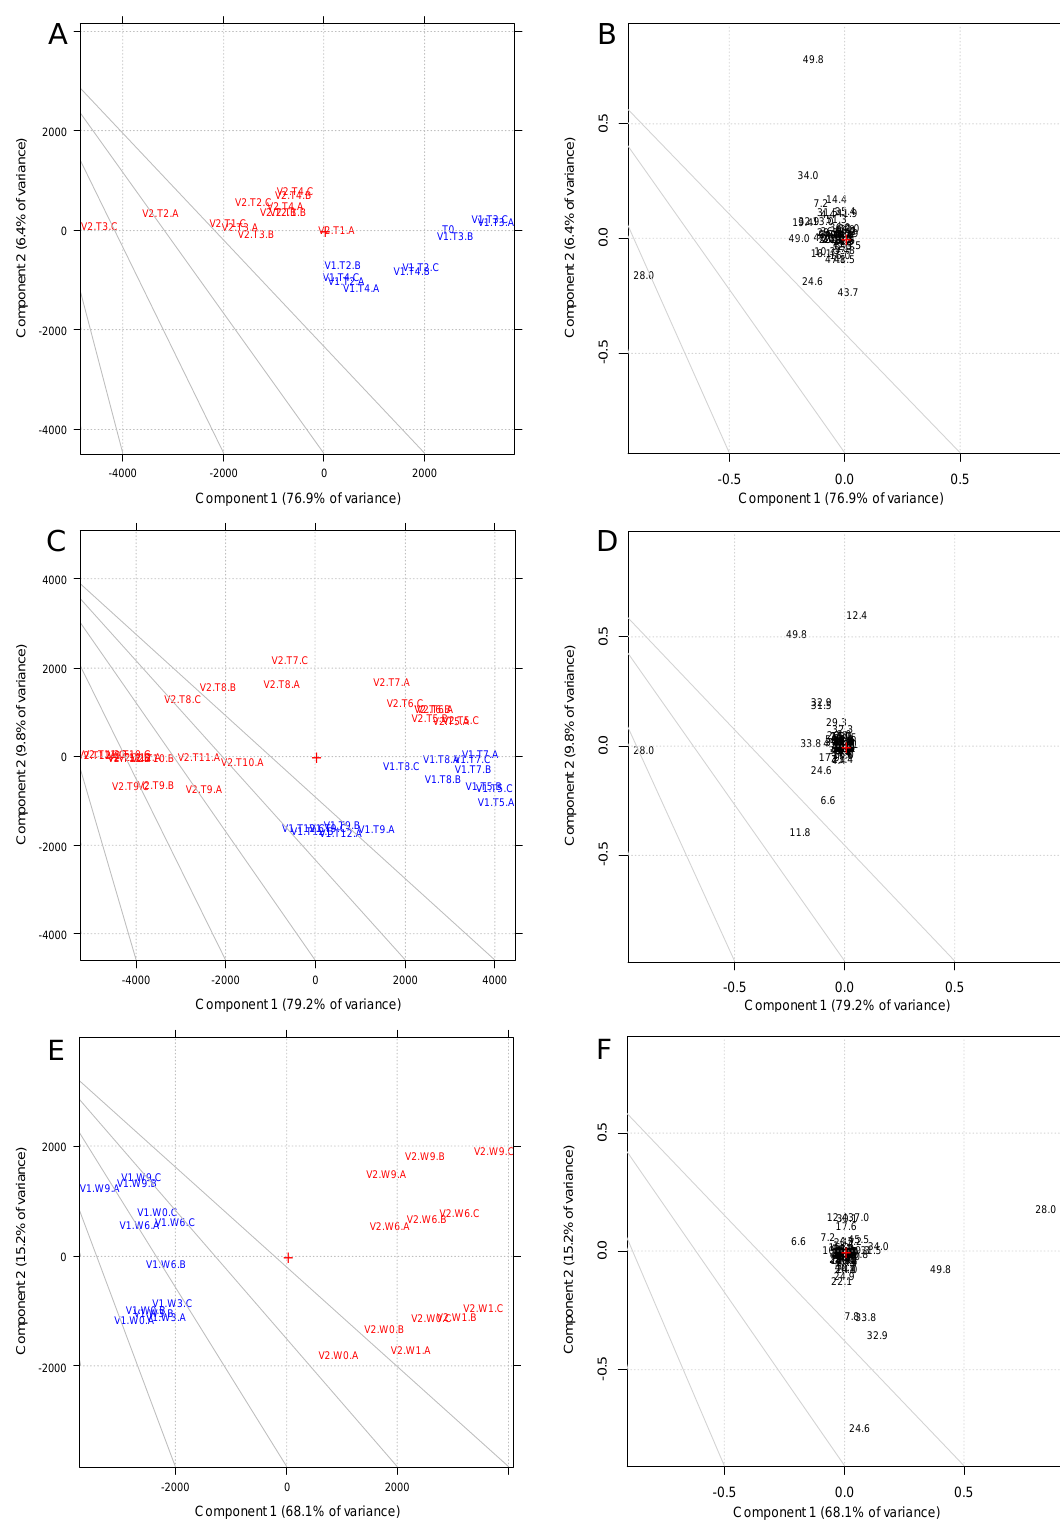
Figure 1. PCA of HPLC-DAD peaks. ( A ) PC1 vs. PC2 score plot for must samples; ( B ) PC1 vs. PC2 loading plot for must samples; ( C ) PC1 vs. PC2 score plot for fermentation and stabilization samples; ( D ) PC1 vs. PC2 loading plot for fermentation and stabilization samples; ( E ) PC1 vs. PC2 score plot for bottled samples; ( F ) PC1 vs. PC2 loading plot for bottled samples. Loadings are indicated with their HPLC retention times as labels. Blue font indicates V1 samples; red font indicates V2 samples. ( A – C ) into the PCA plot indicates the three